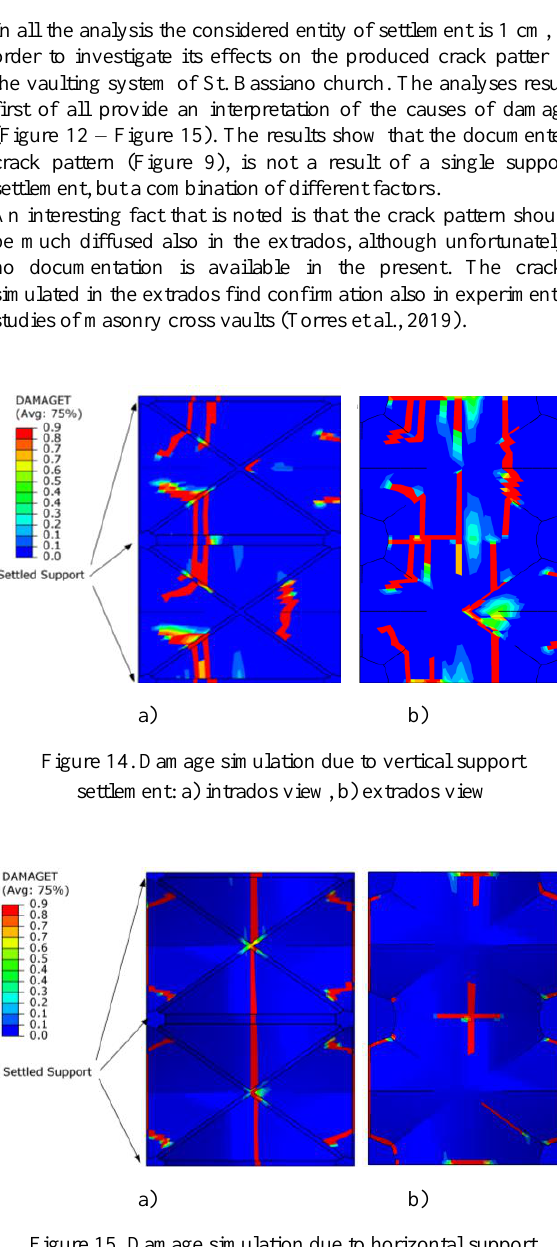
Figure 15. Damage simulation due to horizontal support settlement: a) intrados view, b) extrados